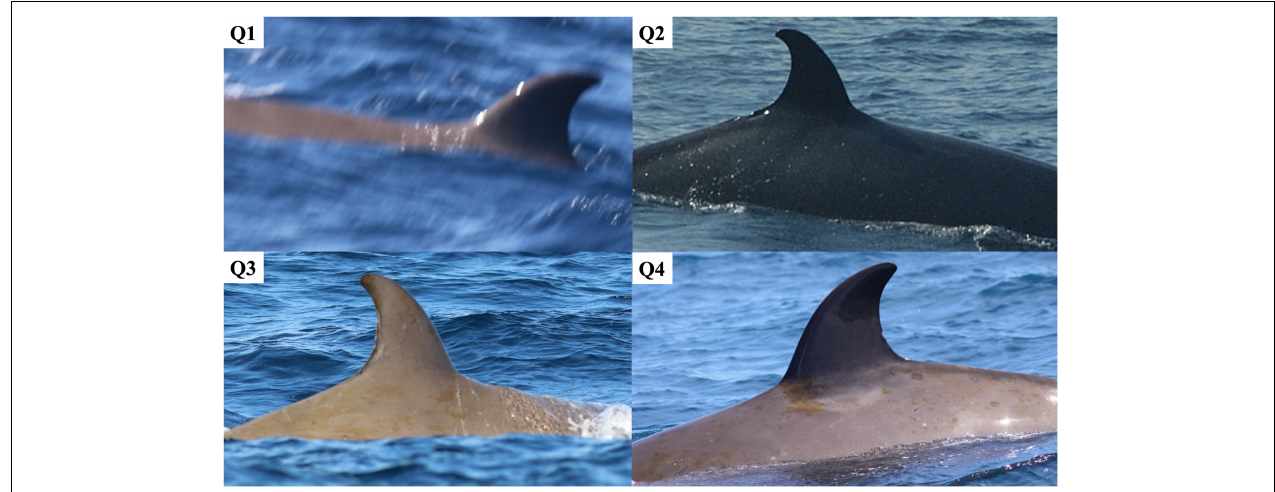
FIGURE 2 | Example quality ratings for dorsal fin photographs. Lowest quality photographs are given Q1 and highest quality photographs are given